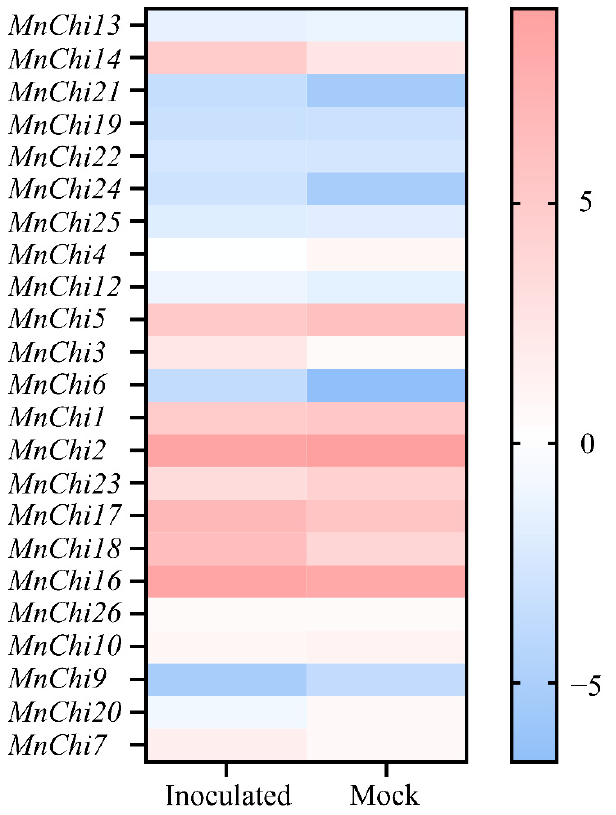
Figure 2. Heat map representation of the chitinase gene expression in mock-treated (Mock) and B. cinerea -inoculated (Inoculated) M. notabilis leaves. Log2 (RPKM) was used to convert the expression data to calculate the gene expression levels. The difference in gene expression was indicated by the color on the scale.